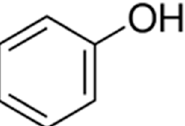
Table 7. Some examples of main polyphenols are found in different types of red fruits.